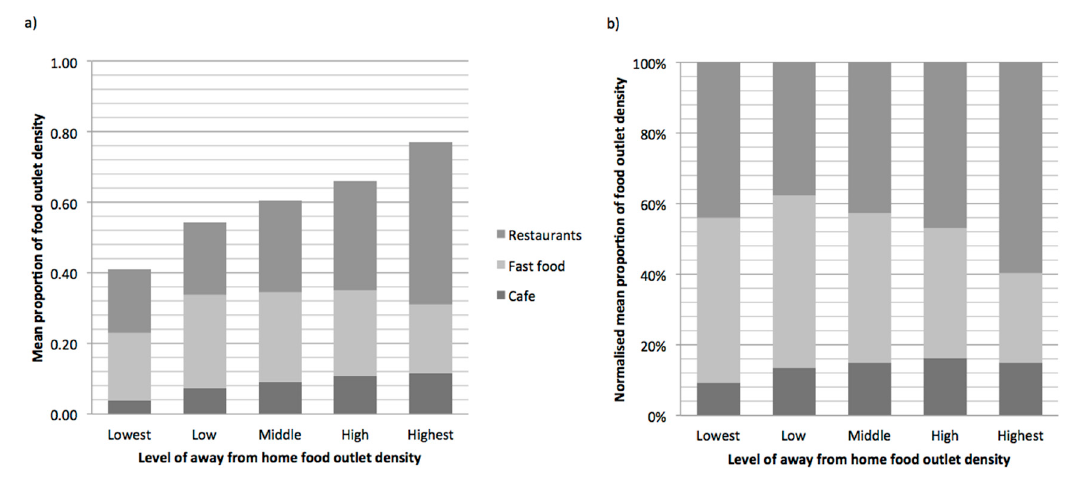
Figure 3. ( a ) Stacked weighted mean % of food outlet density by quintile of away from home exposure for each food outlet type; ( b ) Normalised contribution of weighted mean % food outlet density for type of food outlet by proportion of away from home exposure quintile.